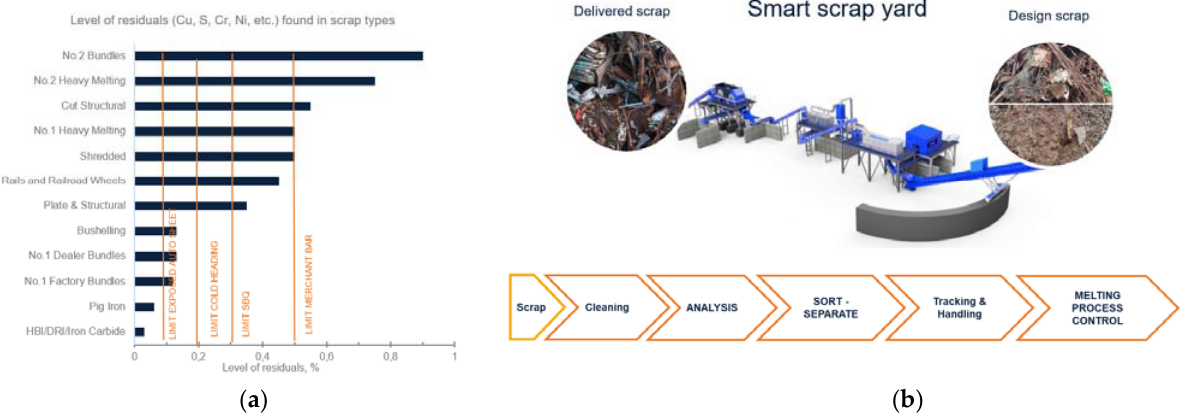
Figure 3. ( a ) Residual element level for different scrap types and limits for steel groups ( b ) Overview scrap processing plant and different process steps.